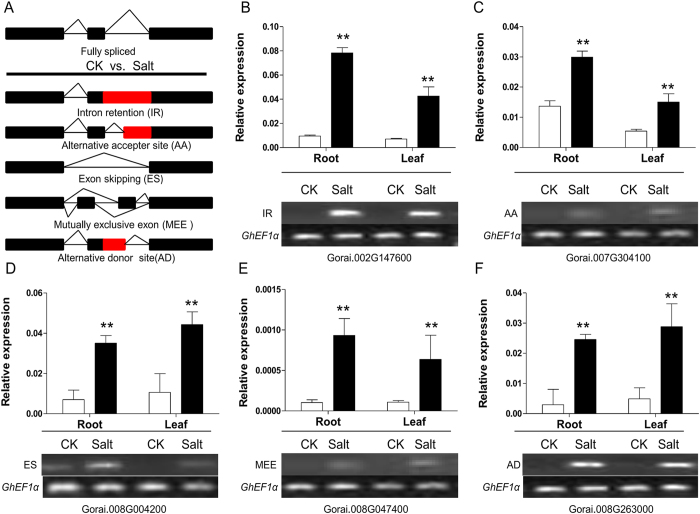
Validation of alternative splicing detected by RNA-Seq through RT-PCR and qRT-PCR.(A) Models for different alternative splicing patterns. Black boxes indicated exons, thick solid lines indicated introns, and flexed lines indicated splice junctions. (B–F) Validation of selected genes with IR (12 h), AA (24 h), ES (48 h), MEE (96 h) and AD (144 h) splicing detected by RNA-Seq analysis both in roots and leaves of G. davidsonii. CK, cotton plants grown under normal conditions; Salt: cotton plants grown under 200 mM NaCl. At least three biological replicates were used. “*” means significant difference at P < 0.05 level; “**” means significant difference at P < 0.01 level. Error bars represent SD.